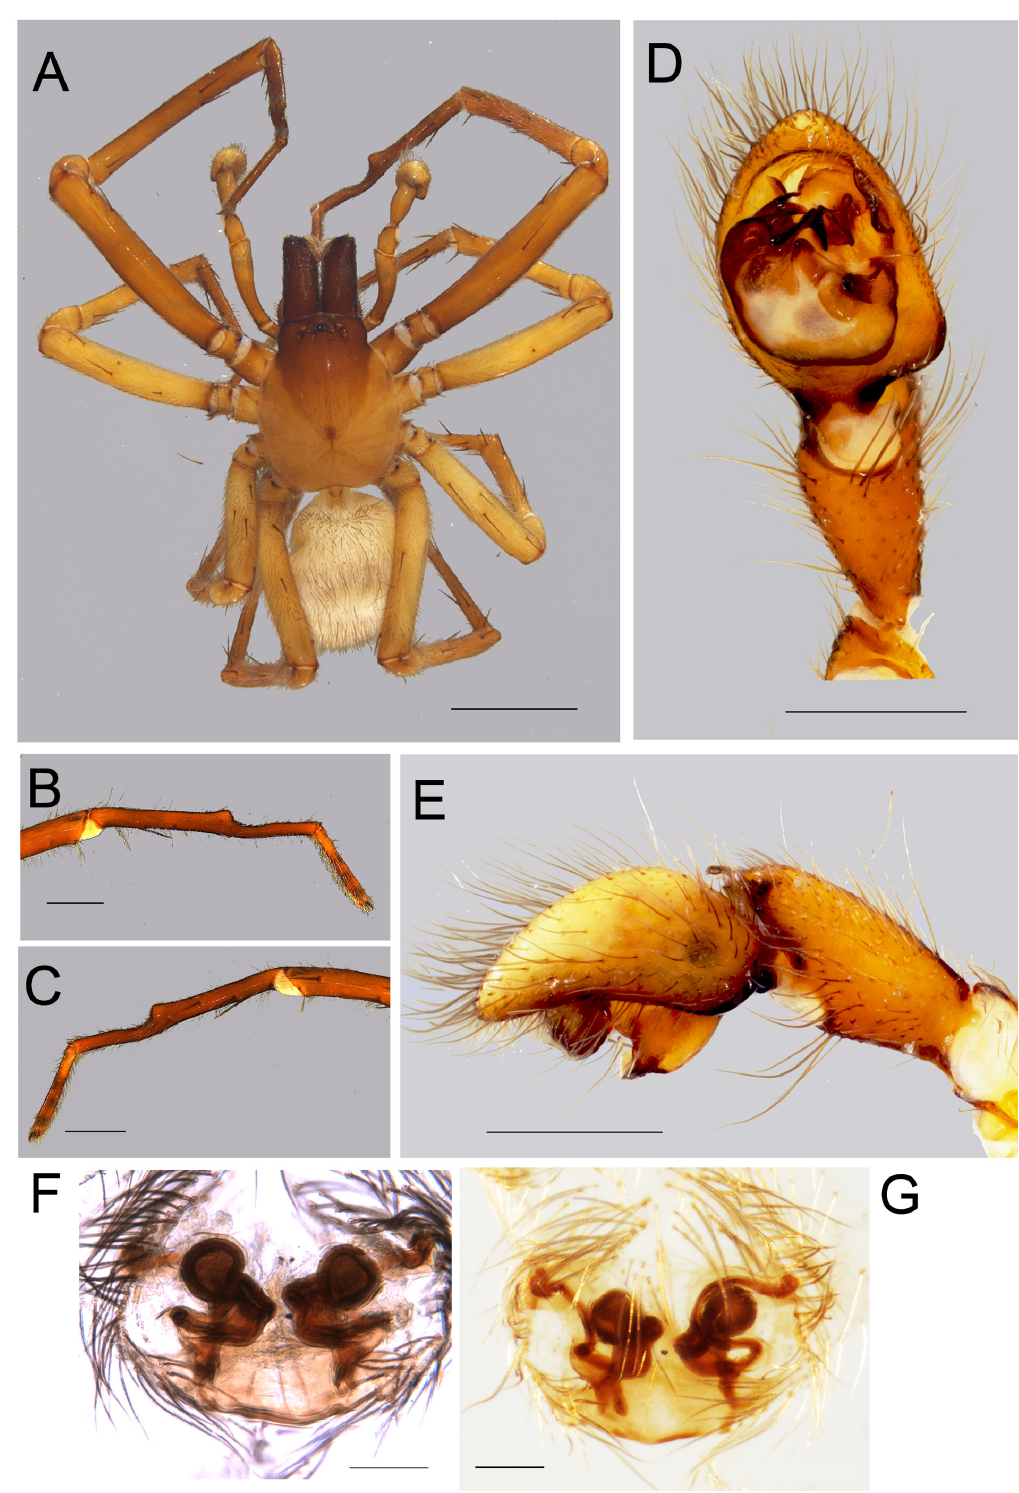
Fig. 6. Xevioso megcummingae sp. nov. A–E . Male holotype (RMCA_ARA_236654). F–G . Male paratype (RMCA_ARA_236655). A . Male habitus, dorsal view. B . MtI, prolateral view. C . MtI, retrolateral view. D . Palp, ventral view. E . Palp, retrolateral view. F . Epigyne, ventral view. G . Epigyne, dorsal view. Scale bars: A = 1 mm; B–C = 0.5 mm; D–E = 200 μm; F–G = 100